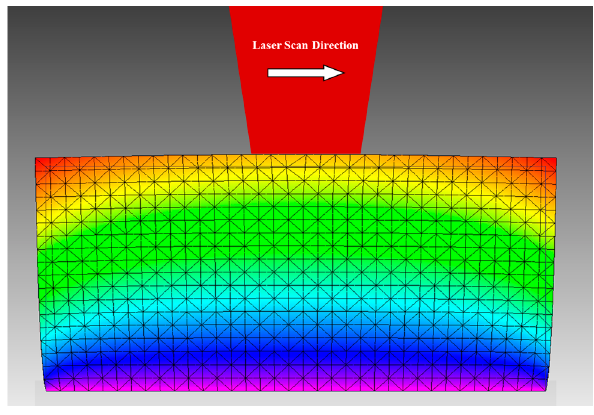
Figure 4. Stress between layers (FEA deformation example).